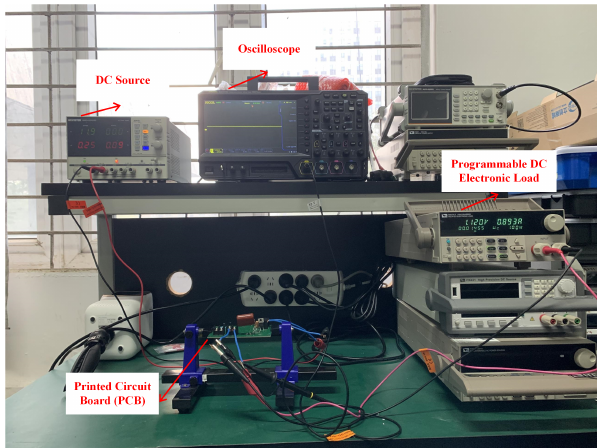
Figure 9. Experimental platform of the